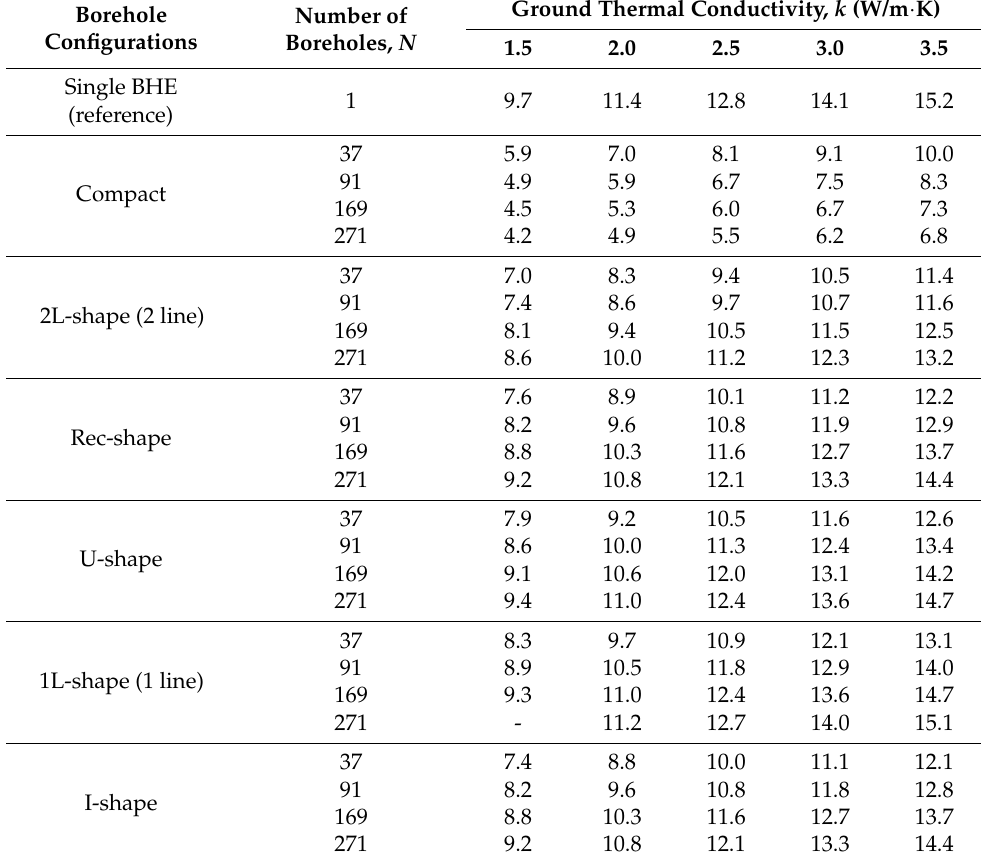
Table A1. Results for heat transfer rate per borehole ( Q bhe ) for cooling-dominant load case.